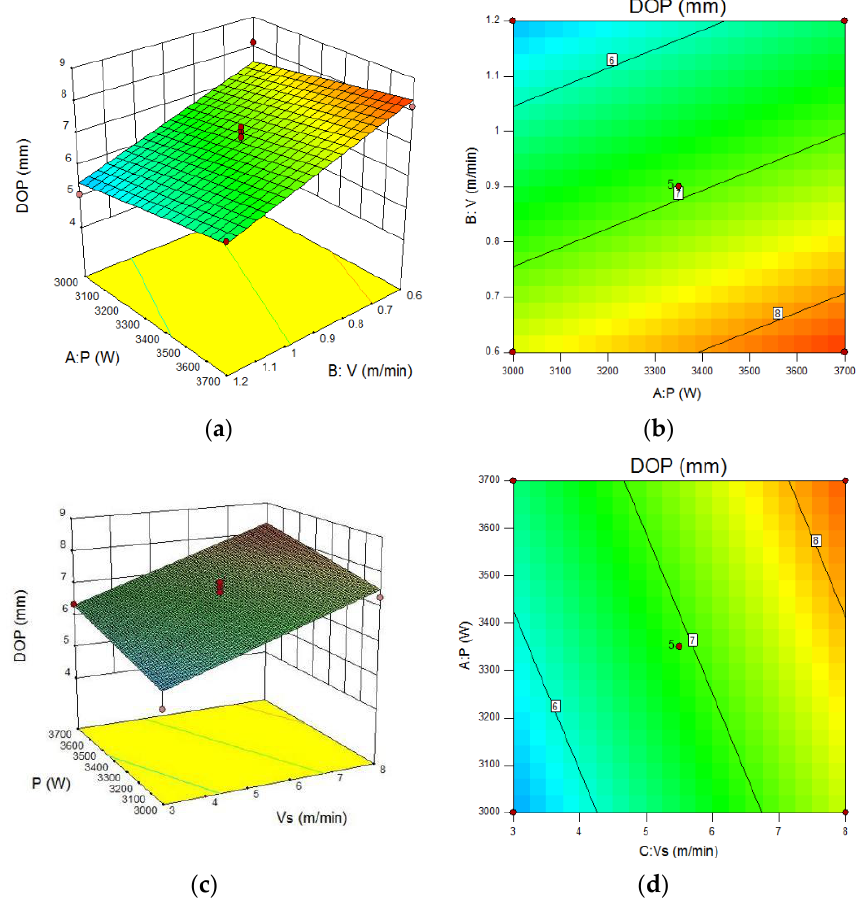
Figure 7. Effect of laser-MAG hybrid welding parameters on weld penetration ( a ) Contour map of P-V, ( b ) Isoline diagram of P-V, ( c ) Contour map of P-Vs, ( d ) Isoline diagram of P-Vs.